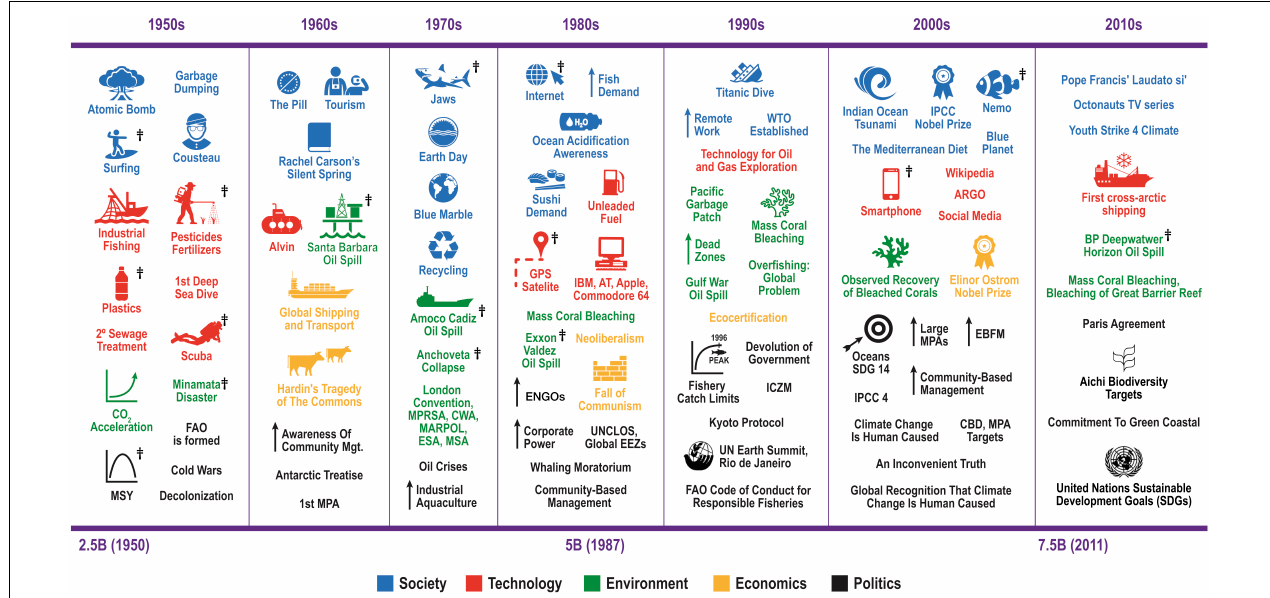
questions are labeled with reference numbers used in Table 1 , corresponding to their research